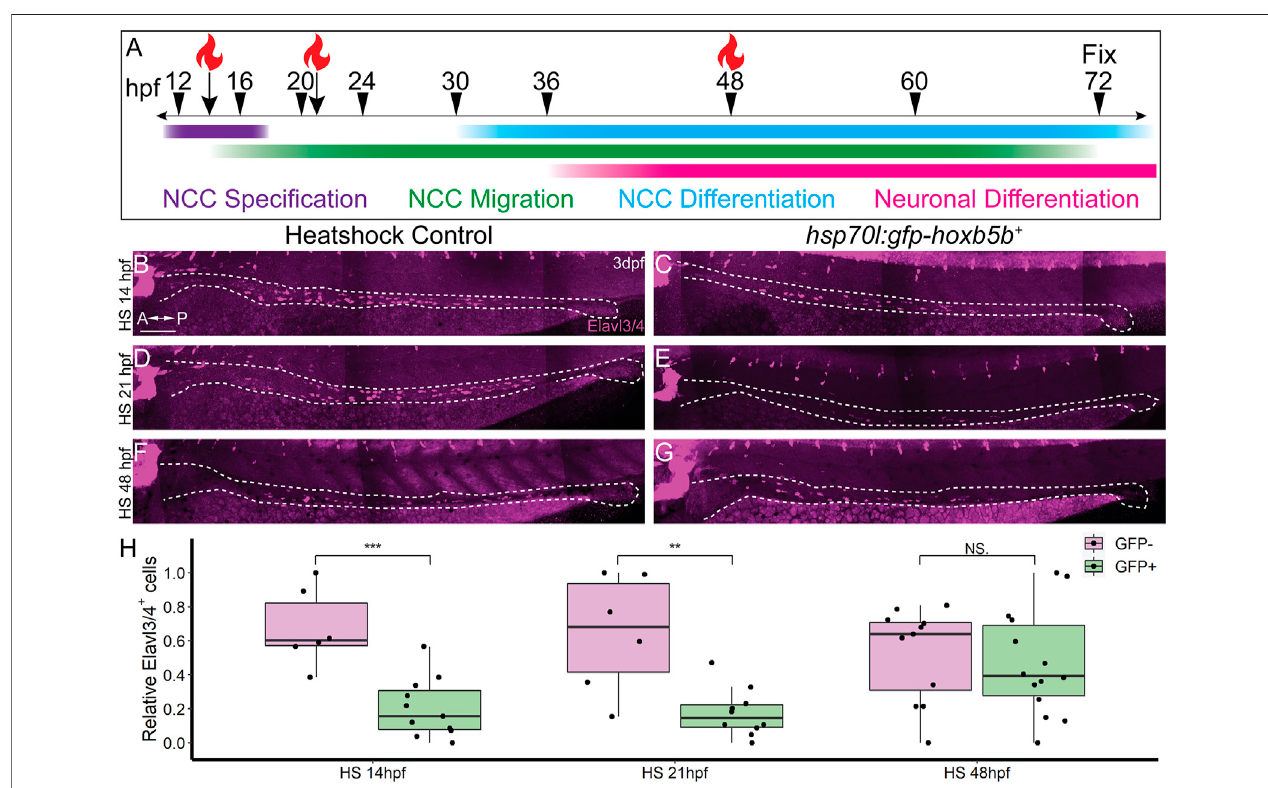
FIGURE 6 | NCC sensitivity to increased Hoxb5b activity is restricted to earlier stages of development. (A) Schematized model of when heat shocks occurred relativetostandard stagesofNCC developmentin zebra fi sh. (B – H) Wholemountimmunolabeled hsp70l:GFP-hoxb5b + embryosand theirGFP- siblingcontrols(HS14: n (cid:1) 6, HS21: n (cid:1) 6, HS48: n (cid:1) 12) using an antibody against Elavl3/4. hsp70l:GFP-hoxb5b + embryos heat shocked either at 14 hpf ( n (cid:1) 11) or 21 hpf ( n (cid:1) 10) both exhibited fewer differentiating enteric neurons than controls, but not embryos heat shocked at 48 hpf ( n (cid:1) 14). Numbers of enteric neurons are quanti fi ed in (H, HS14: p (cid:1) 0.000232; HS21: p (cid:1) 0.001684; HS48: p (cid:1) 0.5813). Scale Bar (B) : 100 μ